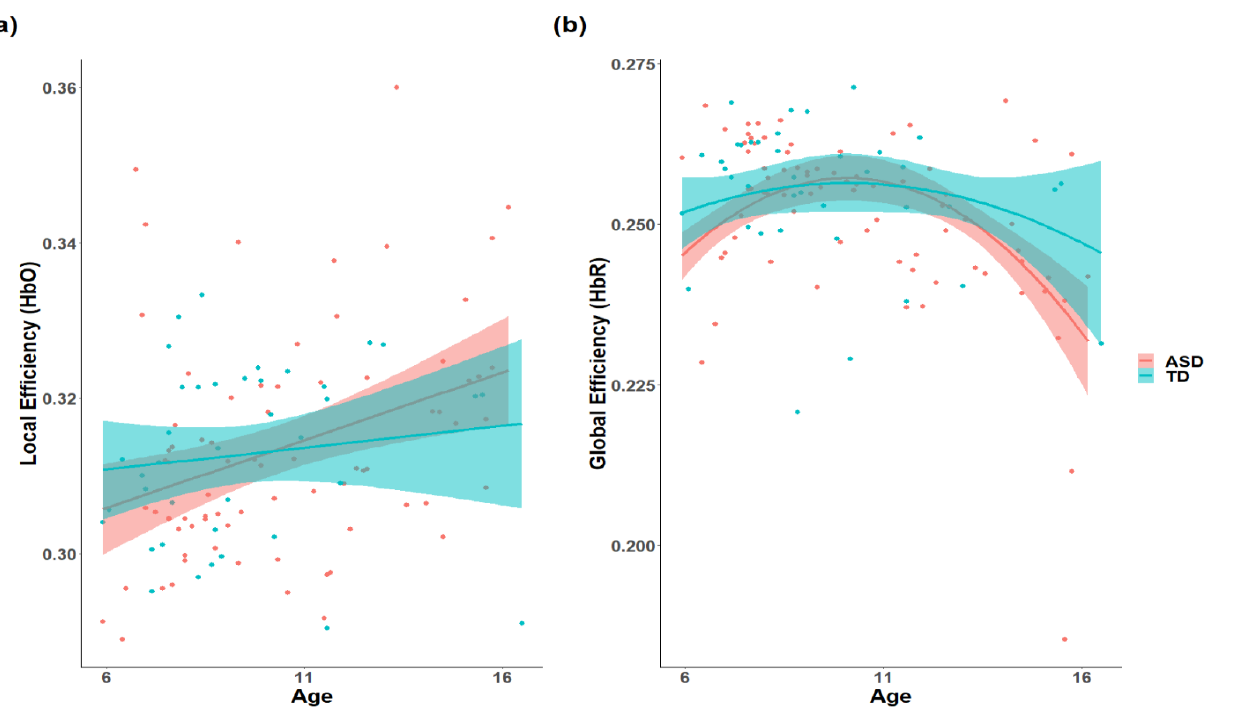
Figure 2. The significant main effect of age on network efficiency. The local efficiency of oxy-hemoglobin (HbO) signals ( a ) showed a positive age effect, while the global efficiency derived from deoxy-hemoglobin (HbR) signals ( b ) showed a significant effect of age-squared.